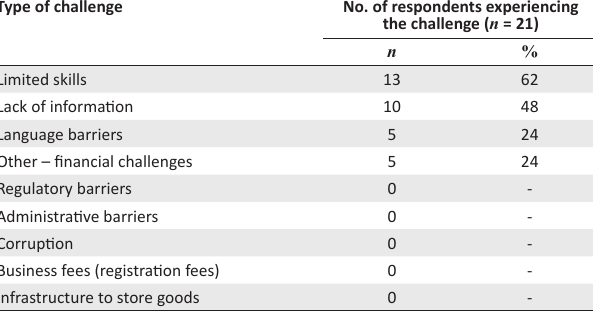
TABLE 3: Barriers to business growth by respondents who want business growth. Type of